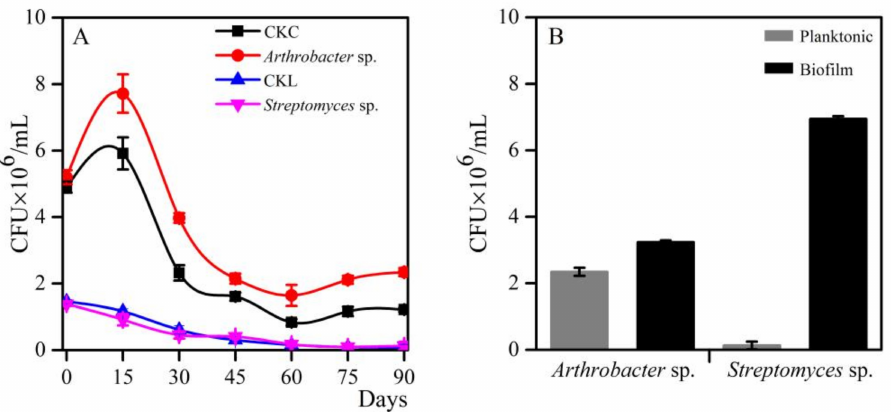
Figure 1. Growth and biofilm formation of Arthrobacter sp. and Streptomyces sp. in the presence of polyethylene (PE) films as a sole carbon source. ( A ) Colony-forming units (CFU) of planktonic bacteria. CKC and CKL indicate Czapek–Dox medium and liquid carbon-free basal medium without PE film and with Arthrobacter sp. and Streptomyces sp., respectively. ( B ) CFU of bacteria in planktonic